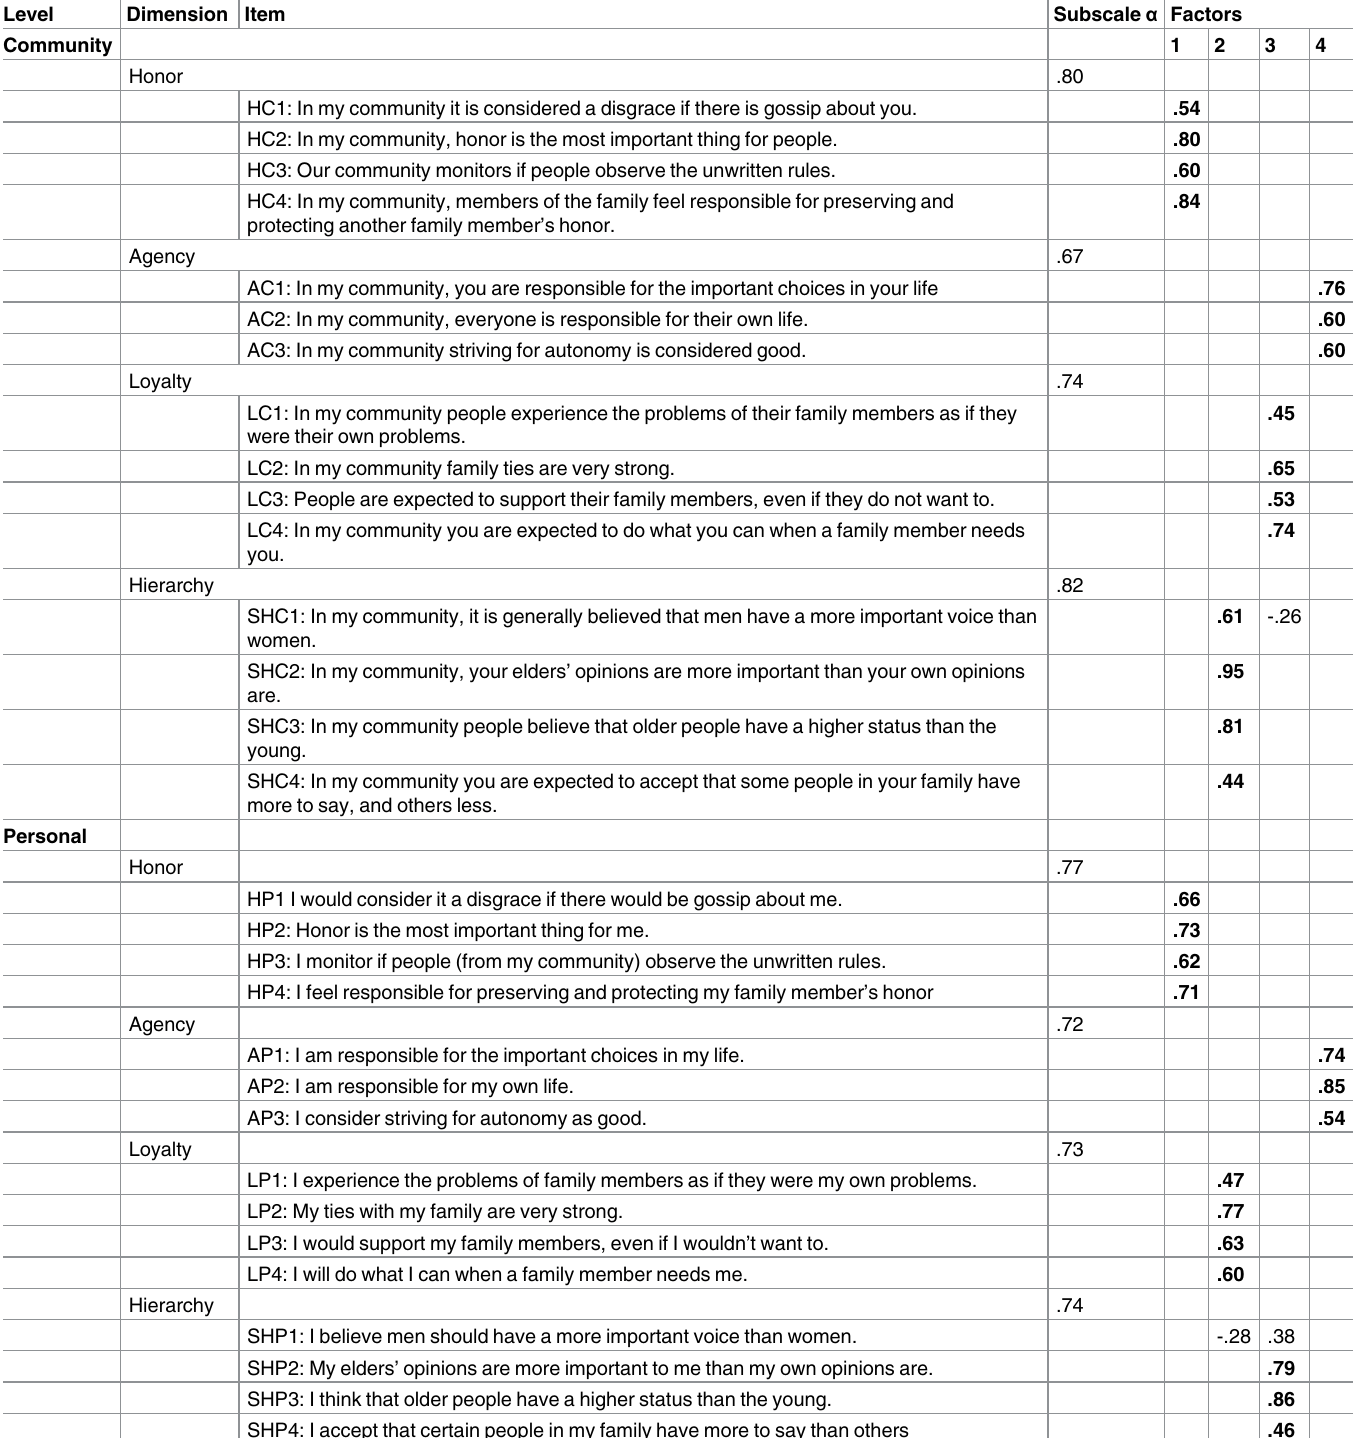
Table 1. Community Collectivism Scale–selected items with factor loadings and scale reliability. Level Dimension Item Subscale α Factors